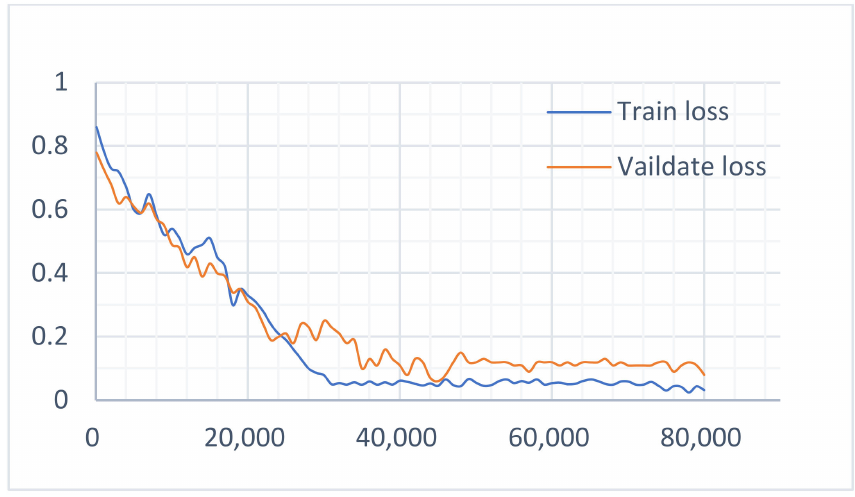
Figure 15. The loss curve of the detection